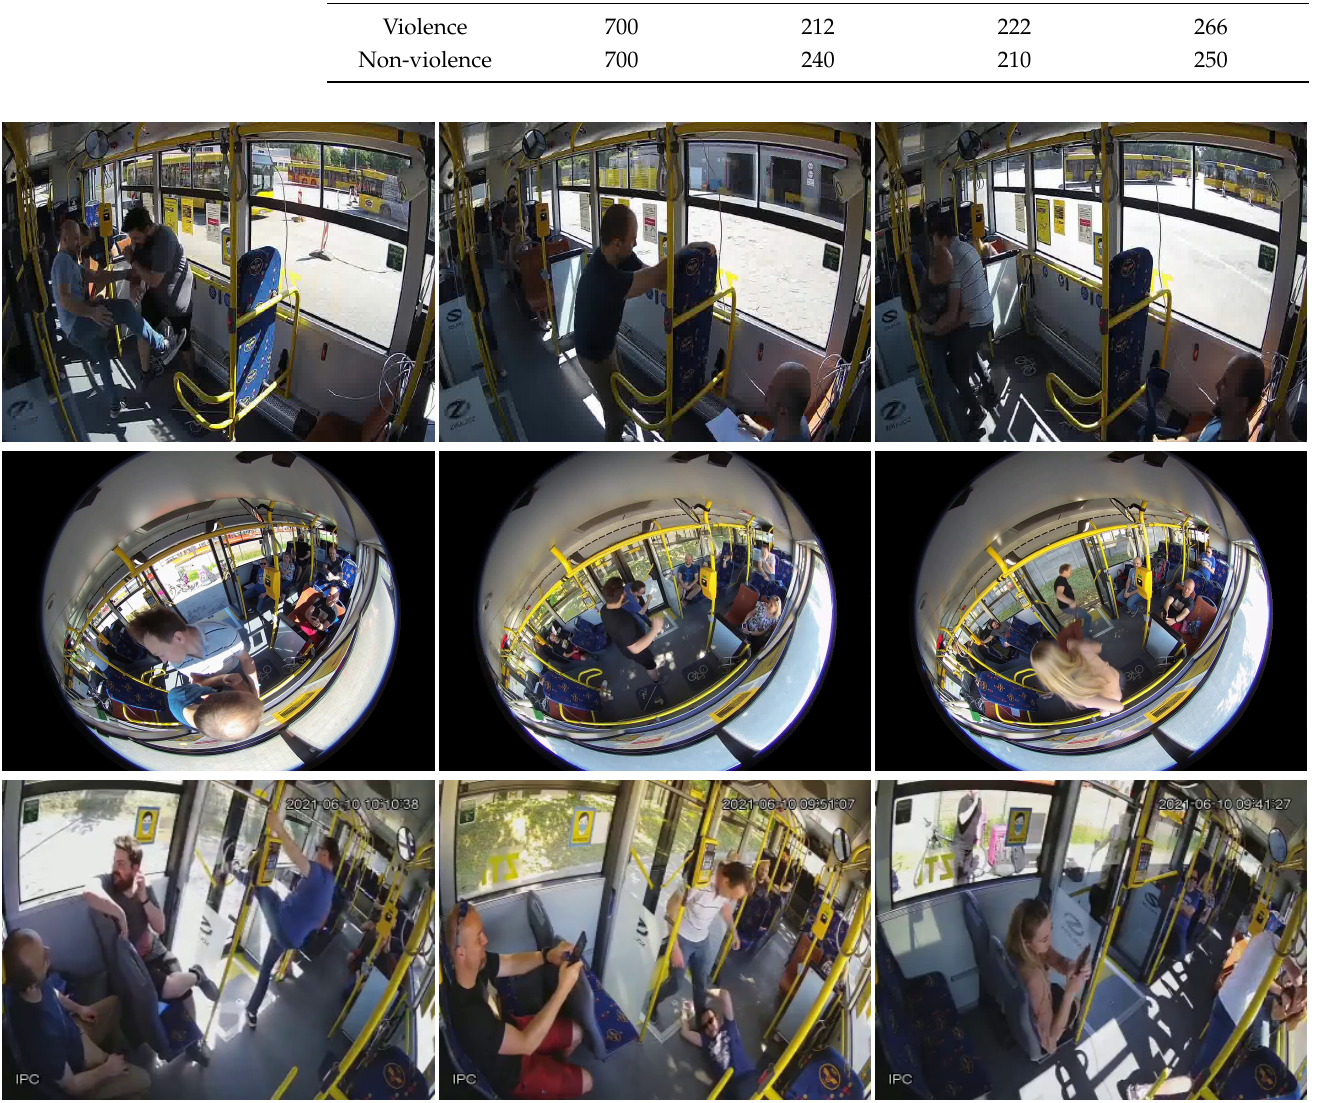
Figure 1. Samples of our Bus Violence benchmark belonging to the violence class, where the actors simulated violent actions, such as fighting, kicking, or stealing an object from another person. Each row corresponds to a different camera having a different